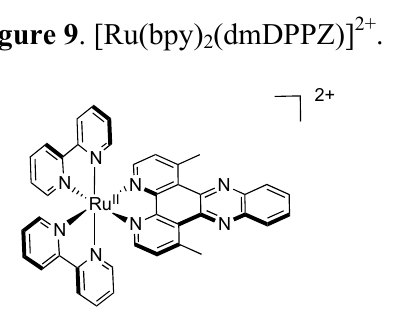
Figure 9 . [Ru(bpy)